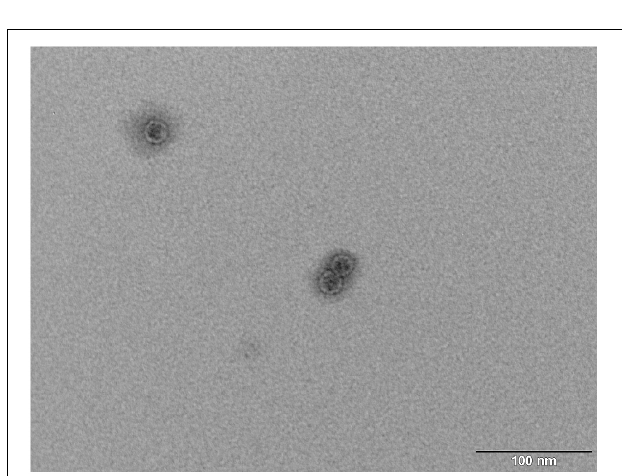
FIGURE 4 | Transmission electron microscopy (TEM) photograph of the intact MS2 phage-like particles (MS2 PLP) after purification steps. The scale is 100 nm.